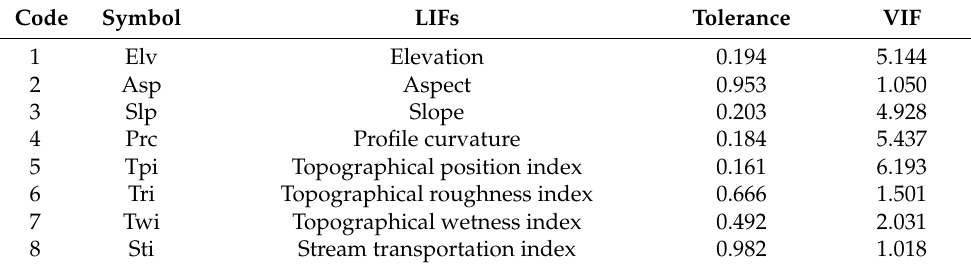
Table 3. VIF and tolerance statistics of